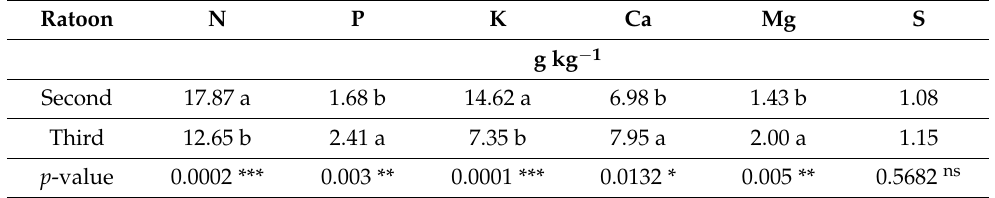
Table 3. Mean levels of macronutrients (leaf + 1) in two sugarcane cycles. Growing seasons 2018/2019 and